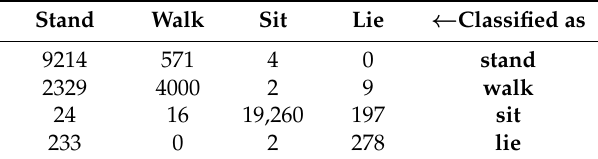
Table A1. Confusion matrix of the PAC system by Bao et al. in in-lab training/out-lab testing